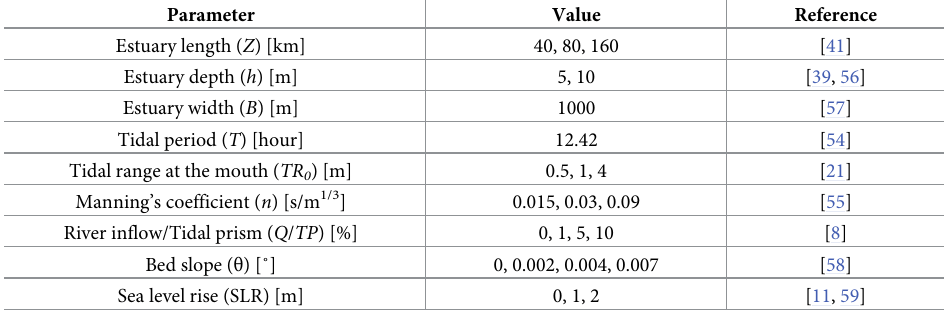
Table 1. Parameters and their values considered in this study to align with reported values of real-world